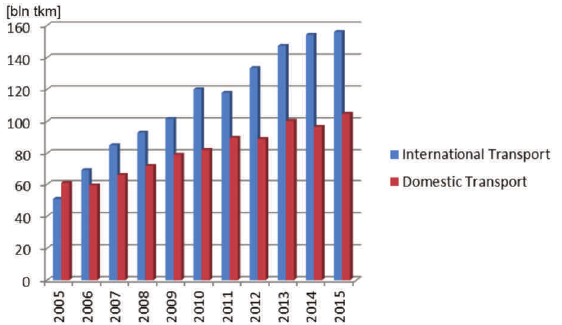
Fig. 1. Haulage work of the Polish freight road transport carried out in the years 2005–2015 by the vehicles exceeding 3.5 Mg GVW [bln tkm] (diagram based on CSO data